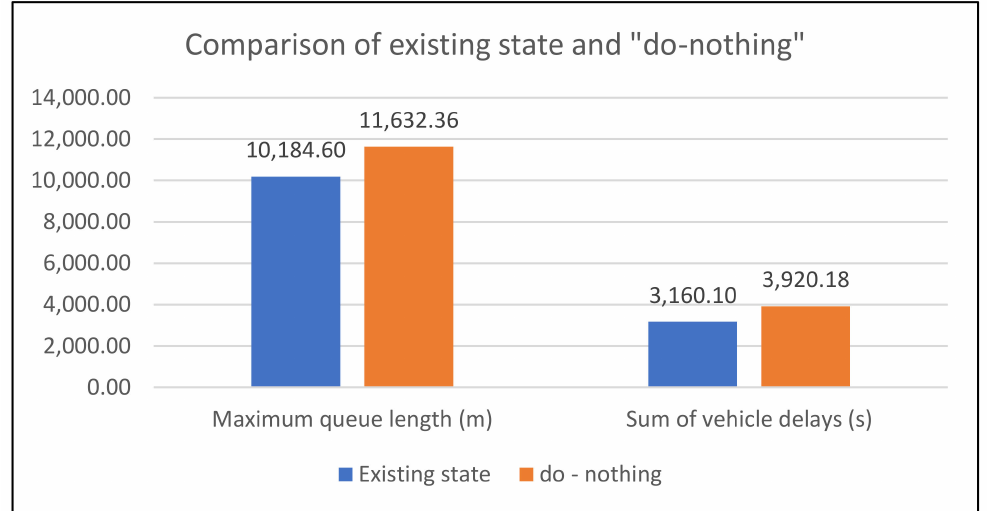
Figure 8. Comparison of maximum queue length and sum of vehicle delays of existing state and scenario “do-nothing” in the morning peak